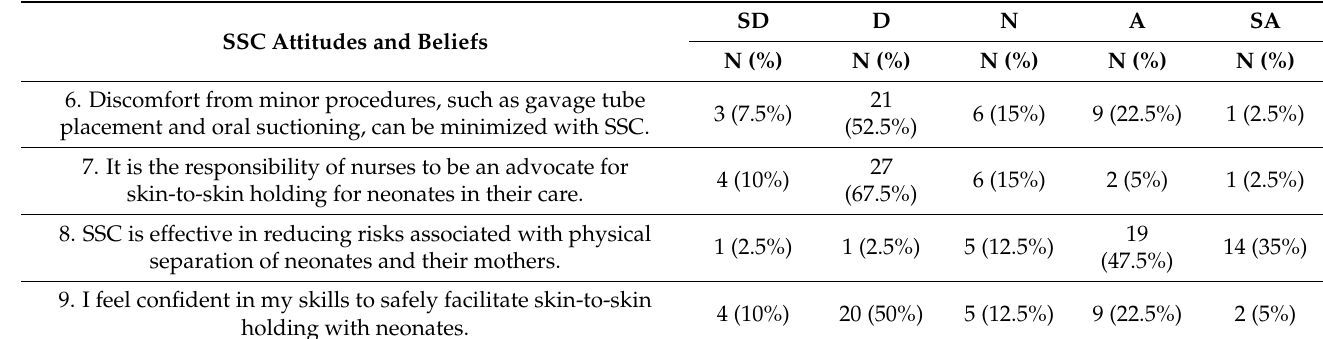
Table 2. Number and percentage of Likert-based responses on the nurses’ beliefs and attitudes toward SSC.